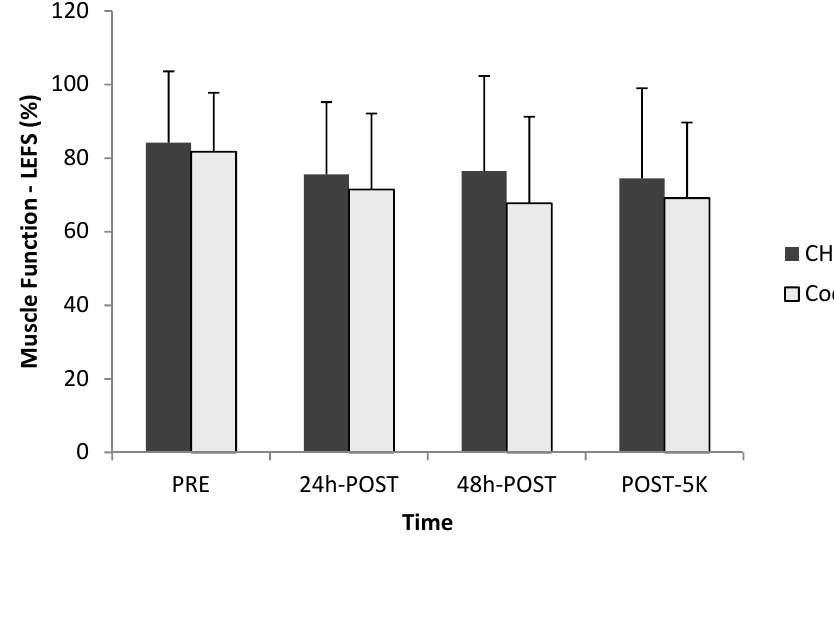
Figure 3. Mean ± SD percent muscle function (LEFS) at PRE, 24 h-POST, 48 h-POST, and POST-5K between treatment beverages. Note: CHOC, chocolate milk; CocoaCHOC, cocoa beverage; LEFS, lower extremity functional